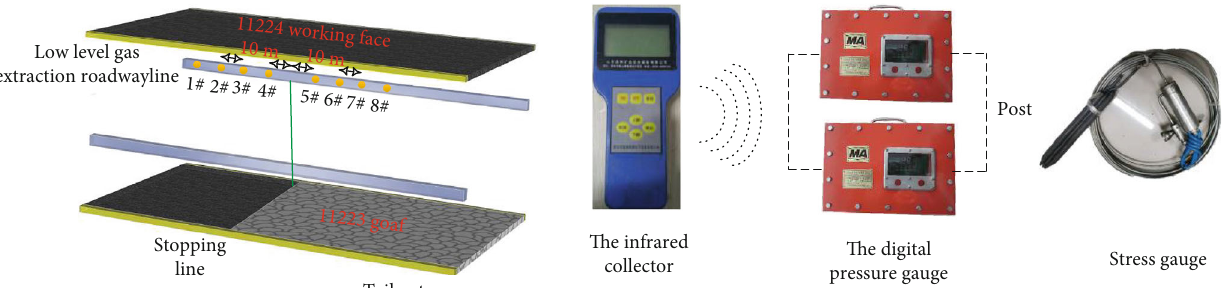
Figure 9: Stress-measuring process using stress gauges, digital pressure gauges, and infrared collector.